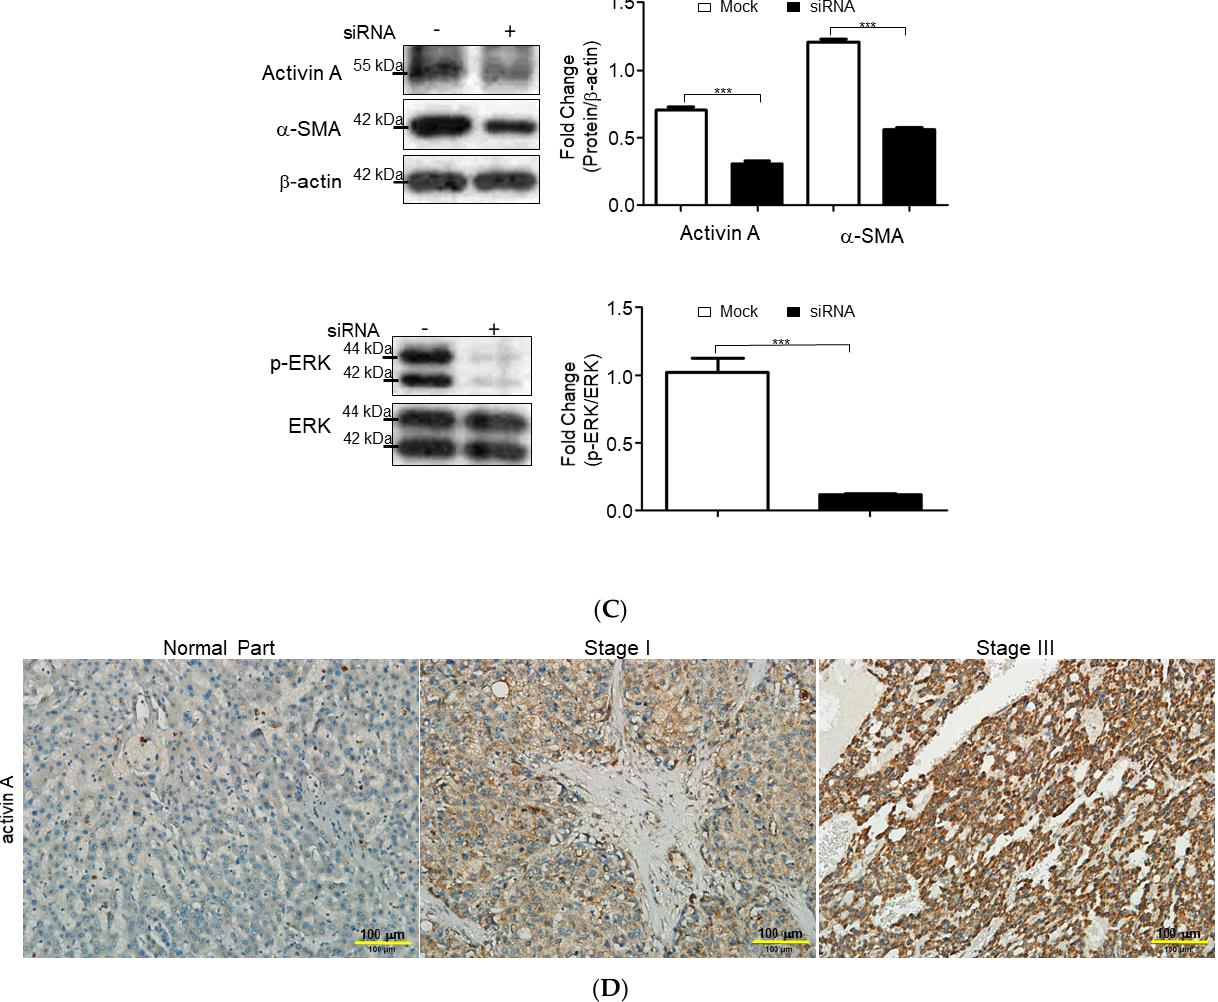
Figure 3. Reveal the overall cytokine/chemokine profile changes by cytokine array. ( A ) Levels of cytokine/chemokine in the aHSC-CM and qHSC-CM were assessed by cytokine arrays. ( B ) The in- tensity of the chemiluminescent signals for each spot was quantified by GeneTools software. Expression levels were normalized with respect to positive controls on the array membrane. The quantitative results indicate the differences in expression values of cytokine/chemokine and demonstrated as a bar chart. ( C ) HSC-T6 cells were transfected with or without siRNA of activin A. Protein levels were measured by Western blot analysis. β -actin was used as an internal control. The quanti- fied results were indicated by the bar chart (*** p < 0.001). ( D ) Immunohistochemical study of activin A expression in adjacent normal part, stage I, and stage III of hepatic cancer tissues. The positive signal was presented in brown (bar scale 100 μ m).